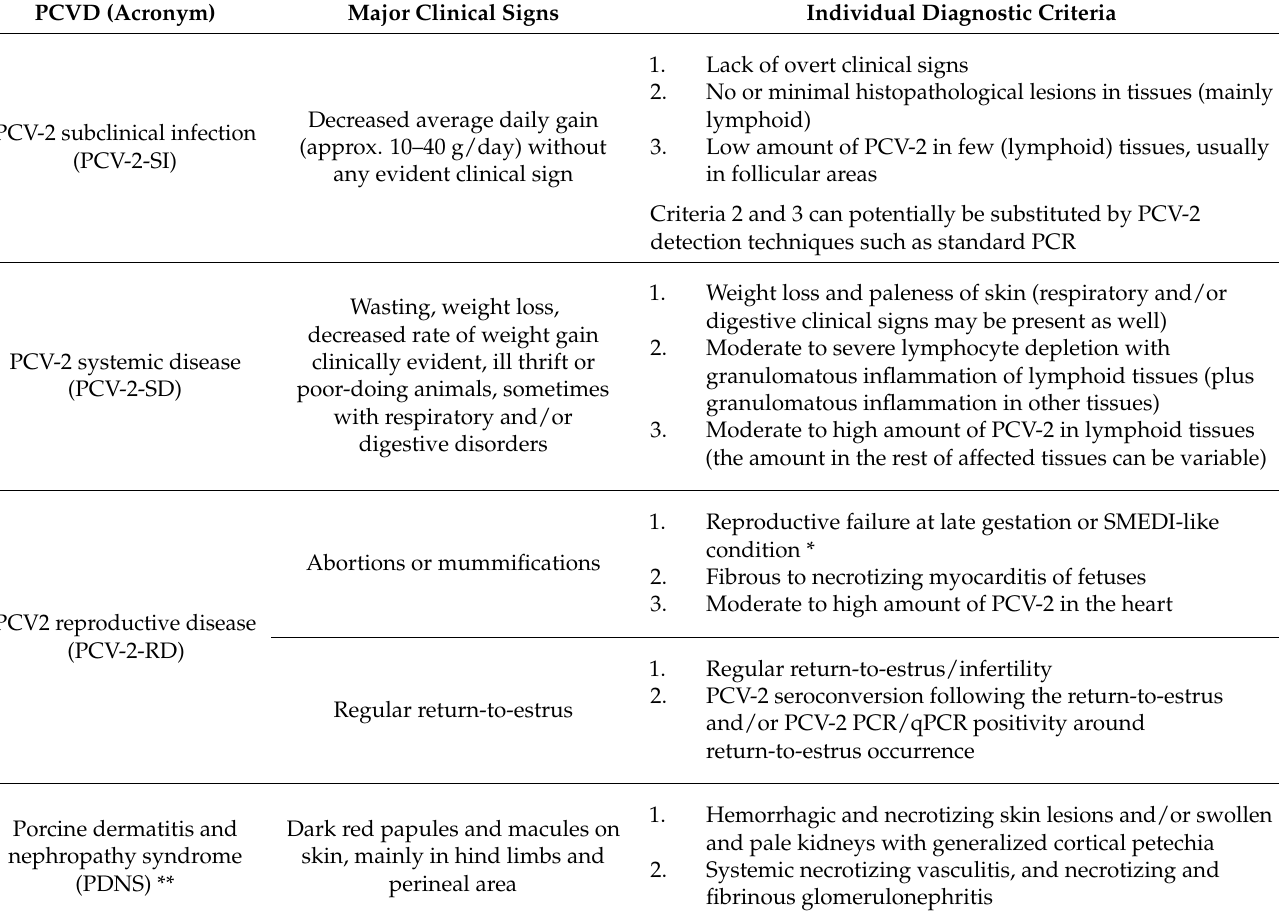
Table 1. Summary of major clinical signs of porcine circovirus diseases (PCVDs) together with their individual case definition based on clinical and laboratorial findings (adapted from Segal é s